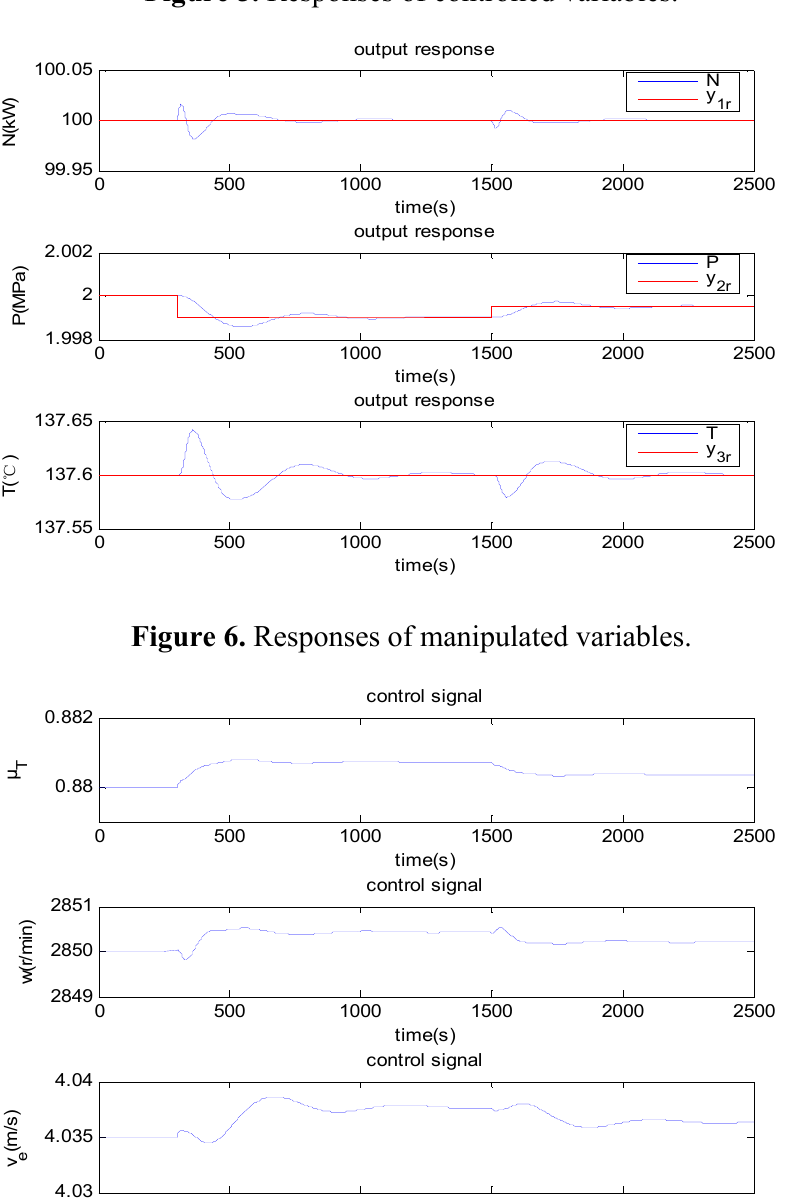
Figure 5. Responses of controlled variables.